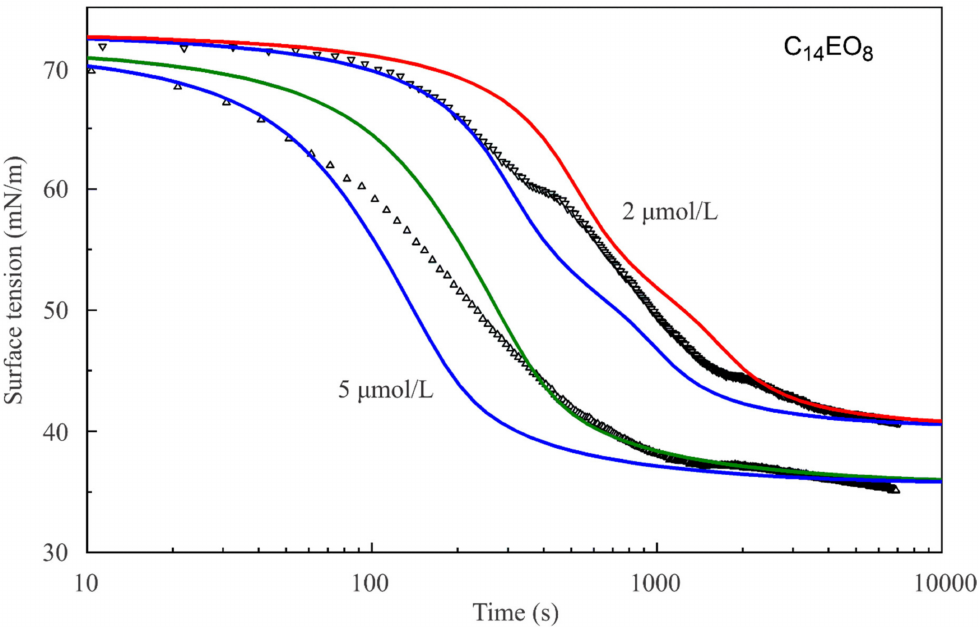
Figure 3. Experimental surface tensions as a function of time measured by PAT-2 for two C 14 EO 8 solutions with concentra- tions of 2 µ mol/L and 5 µ mol/L (symbols), respectively, and the corresponding theoretical curves calculated according to the reorientation model with different diffusion coefficients: 8 × 10 − 10 m 2 /s for both 2 and 5 µ mol/L (blue lines), 6 × 10 − 10 m 2 /s for 2 µ mol/L (red line), and 4 × 10 − 10 m 2 /s for 5 µ mol/L (green